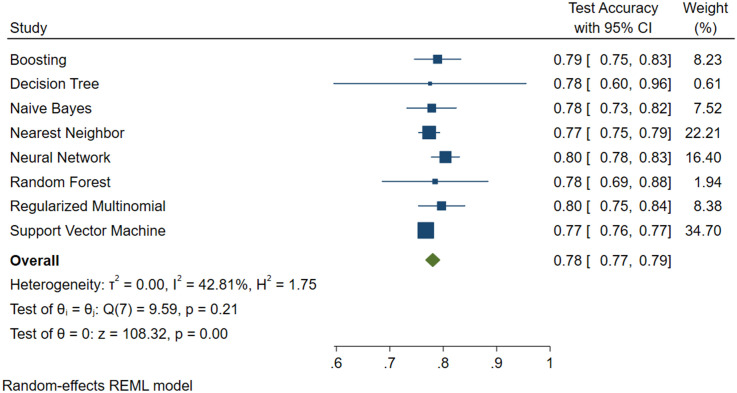
Machine learning applied to NAFLD diagnosis.Forest Plot for the BRI plus Glucose plus GGT plus Age plus Sex Predictive Model.